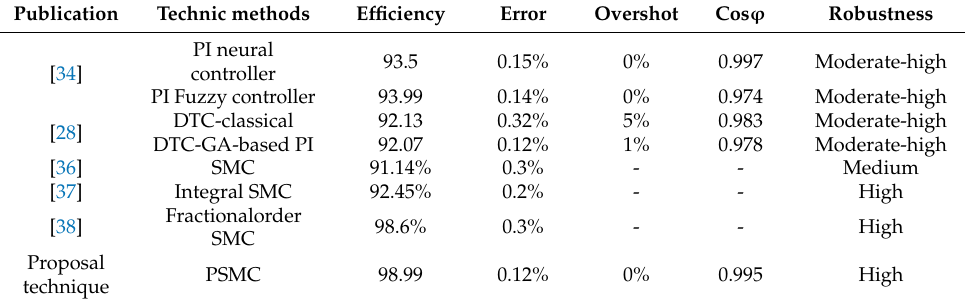
Table 2. Performance